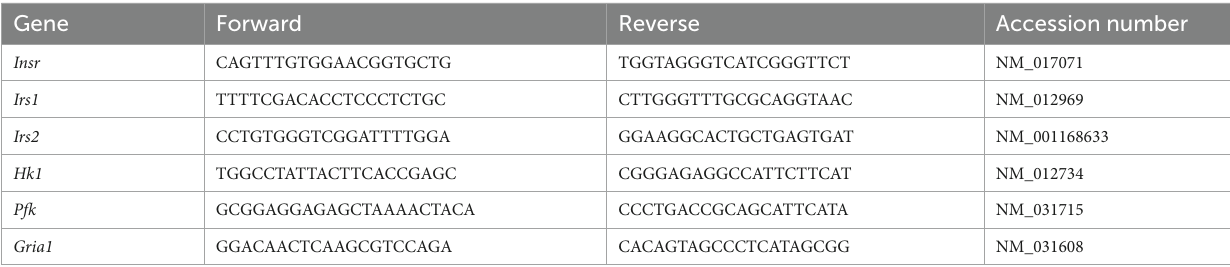
TABLE 1 Primers used for